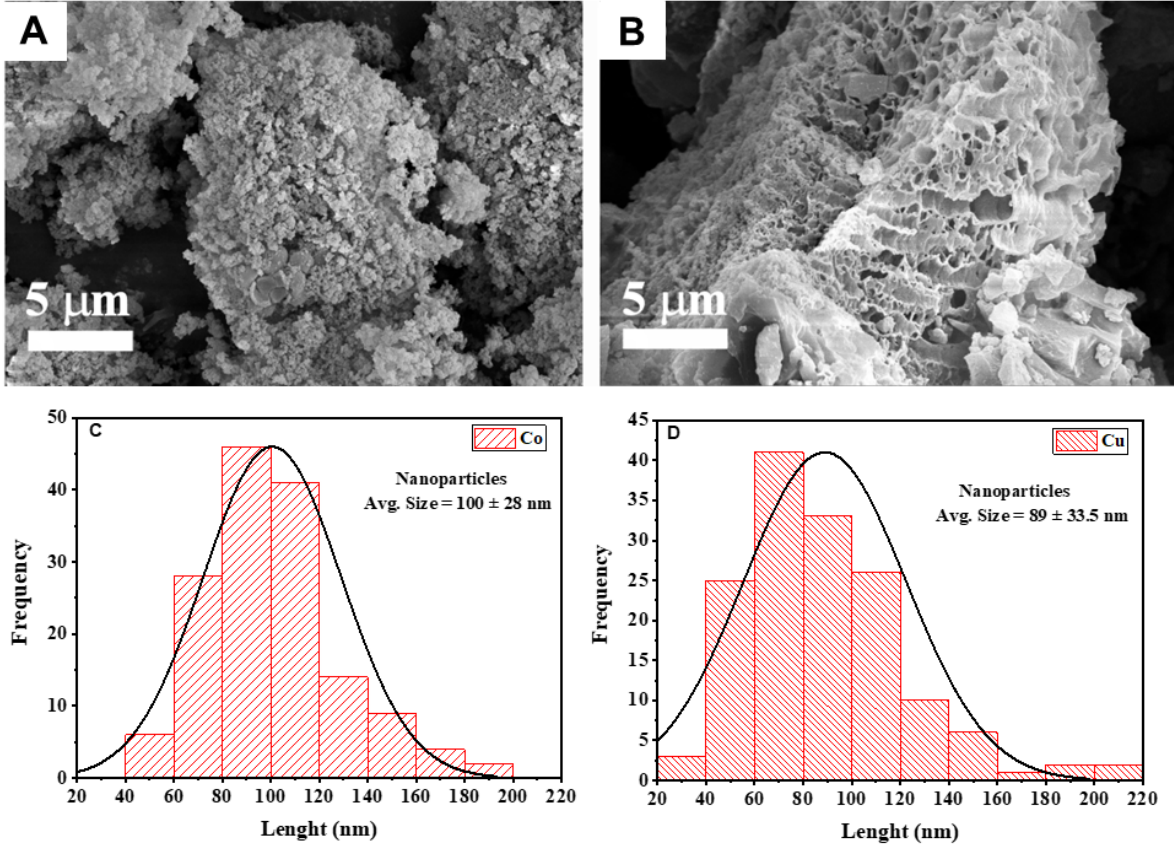
Figure 6. SEM images and average particle sizes of the samples: ( A , C ) Co-abietate; ( B , D )